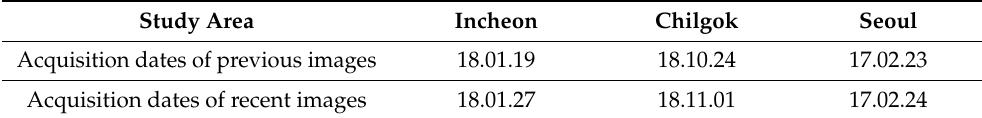
Table 1. Temporal specifications of the Kompsat-3A image sets.